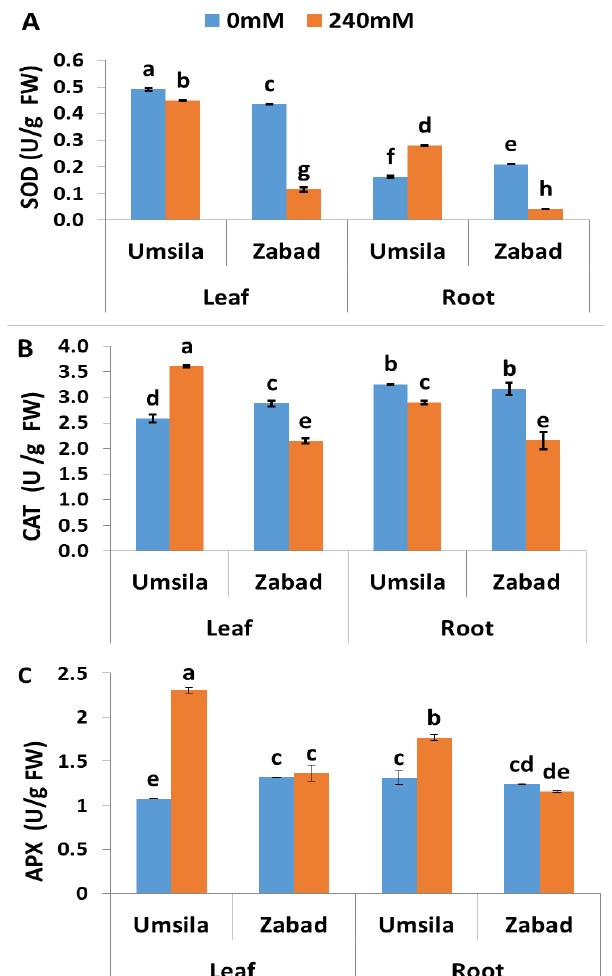
Figure 5. Differential enzymatic antioxidant activity of superoxide dismutase (SOD) ( A ), catalase (CAT) ( B ) and ascorbate peroxidase (APX) ( C ) in date palm seedlings when subjected to control (0 mM NaCl) and salinity (240 mM NaCl) conditions. Bars represent the mean ± SE ( n = 3).